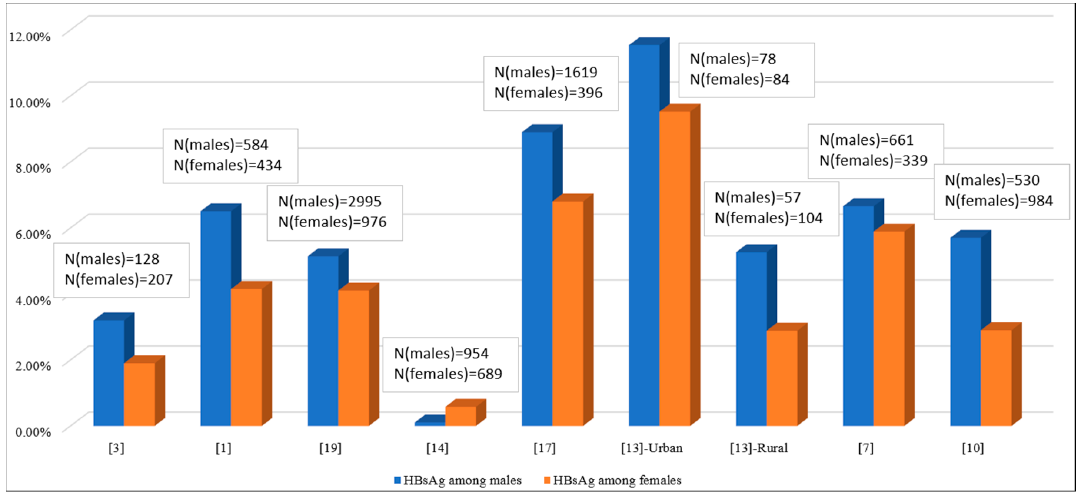
Figure 4. Comparative prevalence of HBsAg between males and females in study populations.